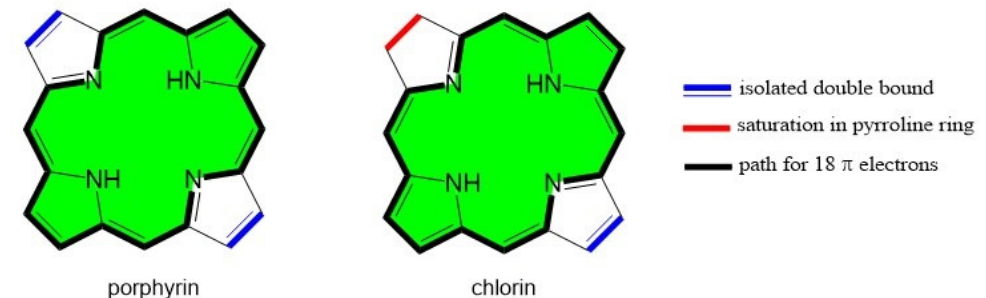
Figure 1. Differences and aromatic paths of chlorin and porphyrin.